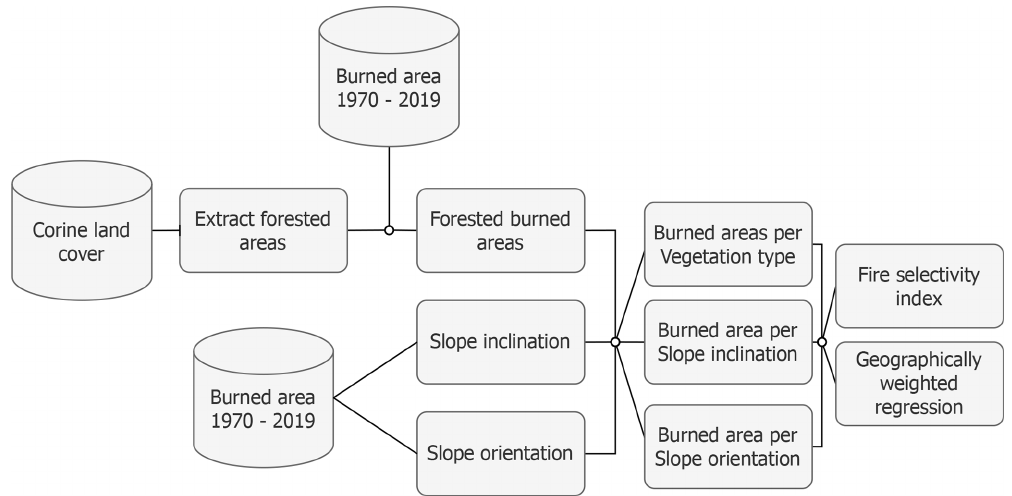
Figure 7. Flowchart depicting the processing steps and data used to relate the burned area to the vegetation type, slope inclination, and